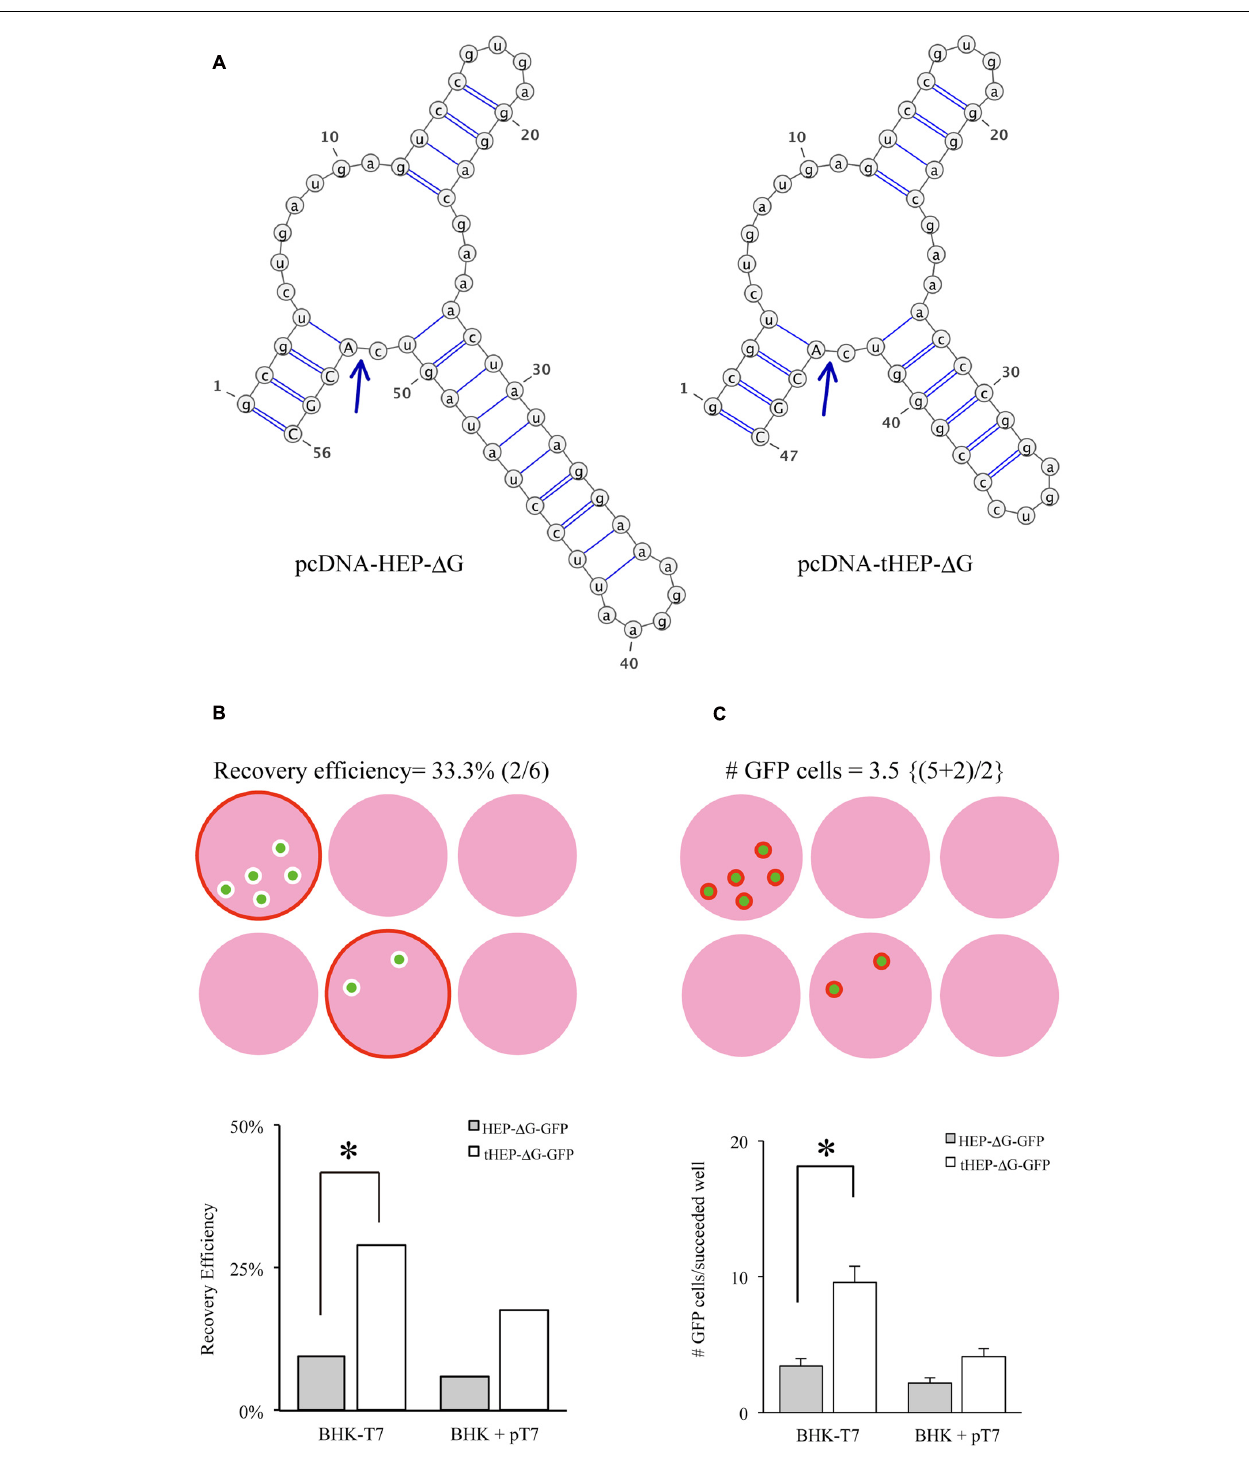
FIGURE 1 | Distinct Hammerhead ribozyme sequences affect the recovery of HEP- Δ G-GFP. (A) Predicted structures of two distinct hammerhead ribozyme sequences, the original (Ham, left) and replacement (tHam, right) HamRz.The four capital letters indicate the 5 (cid:4) end of rabies antigenome RNA. Arrows indicate autocleavage sites. (B) Efficiency of recovery of HEP- Δ G-GFP using HamRz variants.Top, definition of recovery